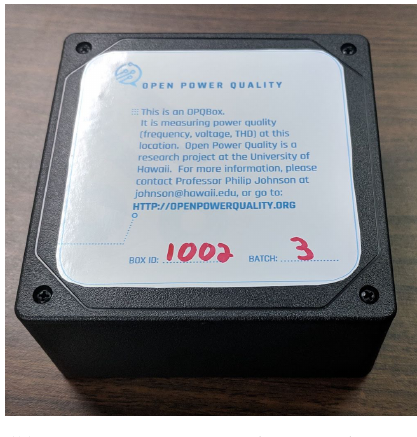
Figure 2. ( a ) OPQ Box block diagram and ( b ) production OPQ Box ready for